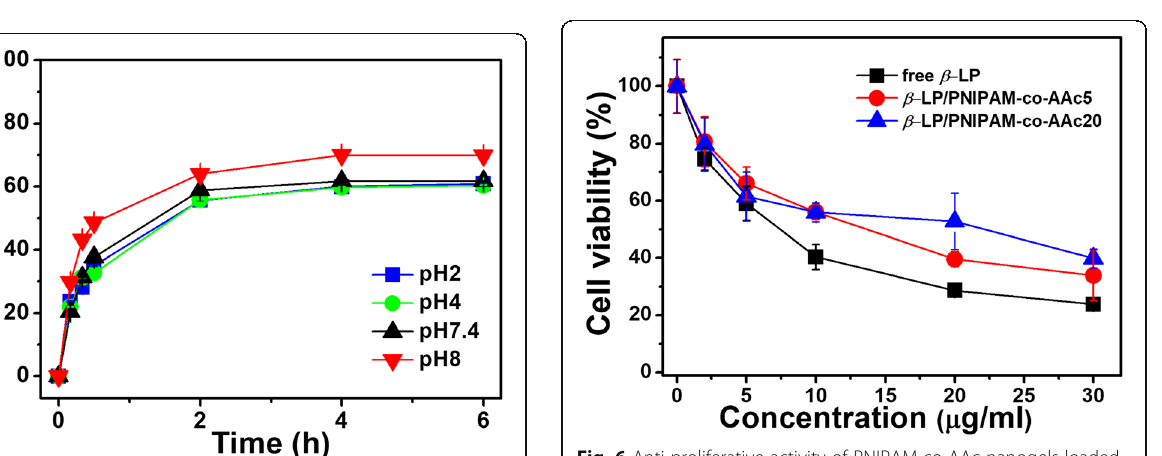
Fig. 6 Anti-proliferative activity of PNIPAM-co-AAc nanogels loaded with β -LP at various concentrations in NIH3T3 fibroblast cells for 3 h at 37